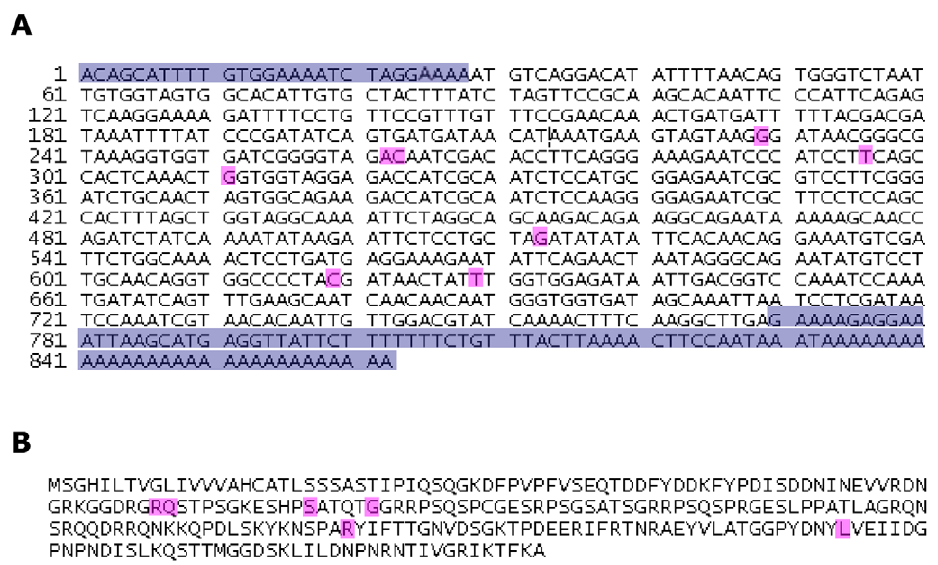
Figure 2. Sequences of the Tunisian Phlebotomuspapatasi 32 kDa salivary protein. ( A ) mRNA sequence of PpSP32. ( B ) Protein sequence of PpSP32. Differences in the nucleotide and protein sequence PpSP30 described in the GenBank (GenBank AF335490.1) are highlighted in pink. Non coding sequence is highlighted in purple.